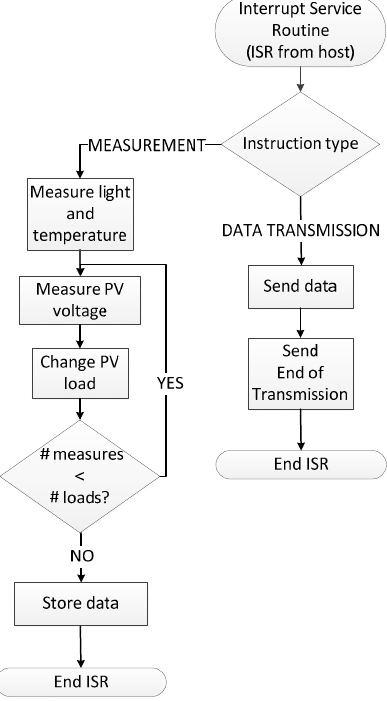
Figure 3. System software dataflow.